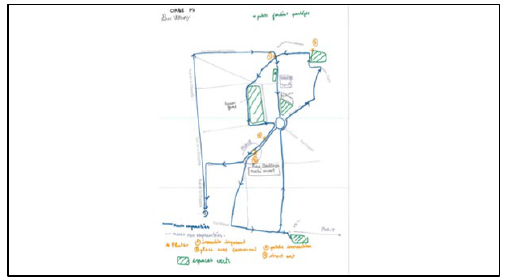
Figure 5. Example of landmarks